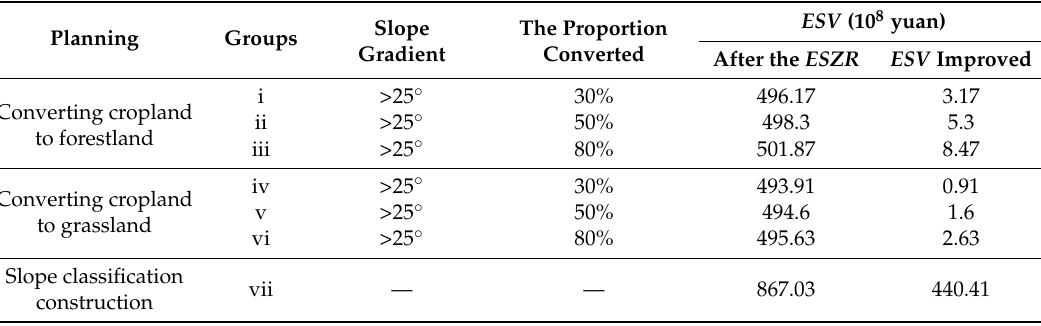
Figure 13. Spatial distribution of ESV : before ESZR ( a ); and after ESZR ( b ). Table 5. Comparison of the ESV , before and after ESZR.